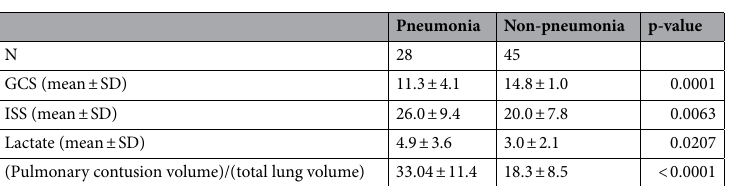
Table 3. t-test for the pneumonia and non-pneumonia groups. GCS Glasgow coma scale, ISS injury severity score, SD standard